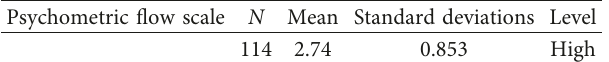
Table 4: Means and standard deviations of students’ scores on the psychometric flow scale.